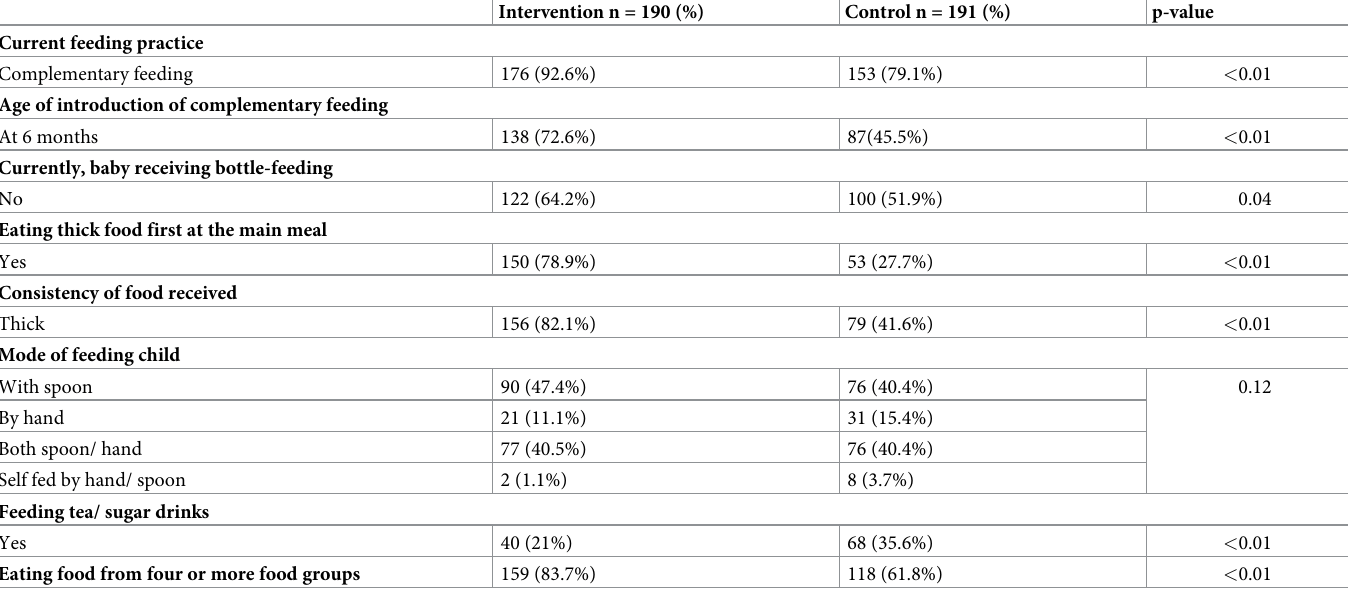
Table 5. End-line comparison of feeding practices of infants in the intervention and control